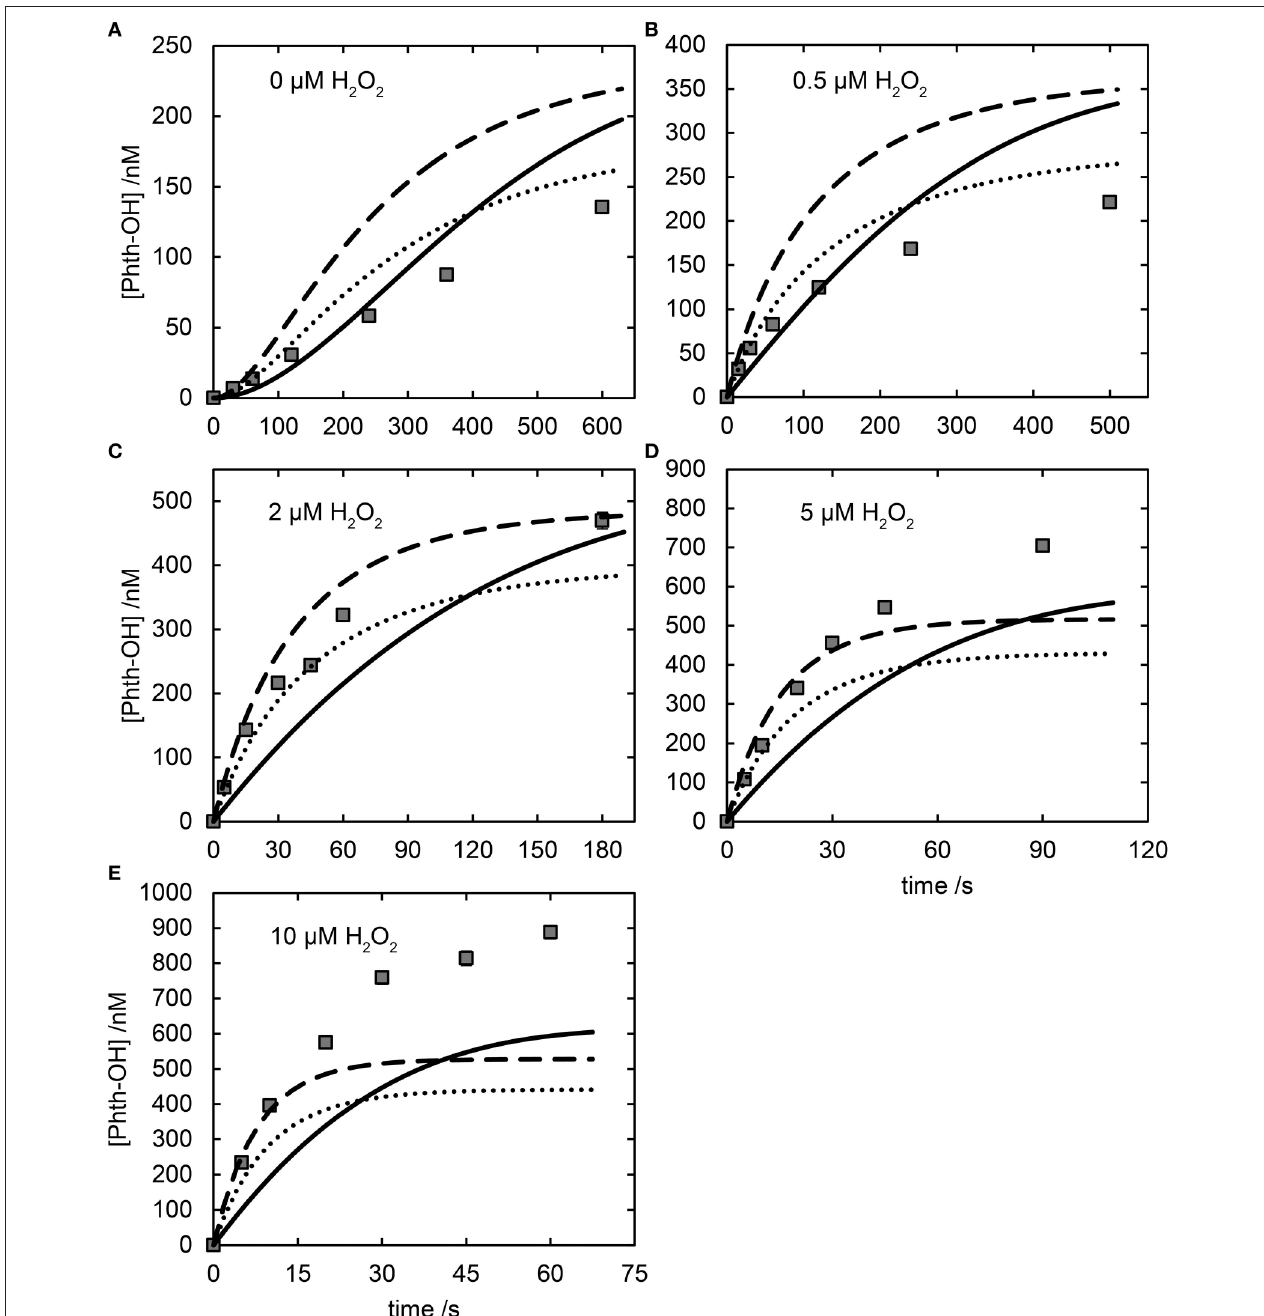
FIGURE 5 | Comparison of experimental data and model results for HO • production by Fe(II)cit when oxidized by H 2 O 2 (0–10 µ M, panels A–E respectively). In all panels [Fe(II)] = 2 µ M, [cit] = 1 mM, experimental data are shown as symbols, the Fe(II)L model as a dashed line, the Fe(II)L-2 µ M model as a dotted line and the Fe(II) 2 L model as a solid